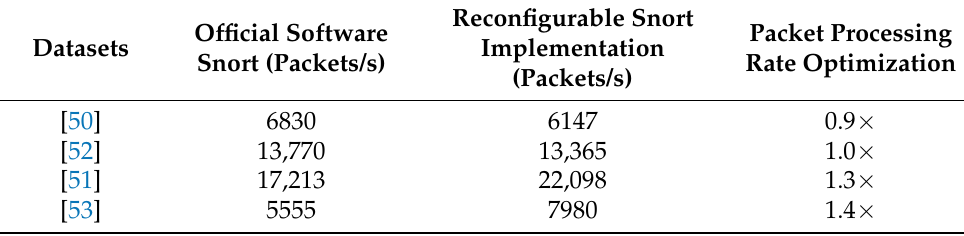
Table 3. Network packet processing rate comparison between the official fully-optimized Snort implementation framework vs. the reconfigurable Snort implementation on a PYNQ platform.